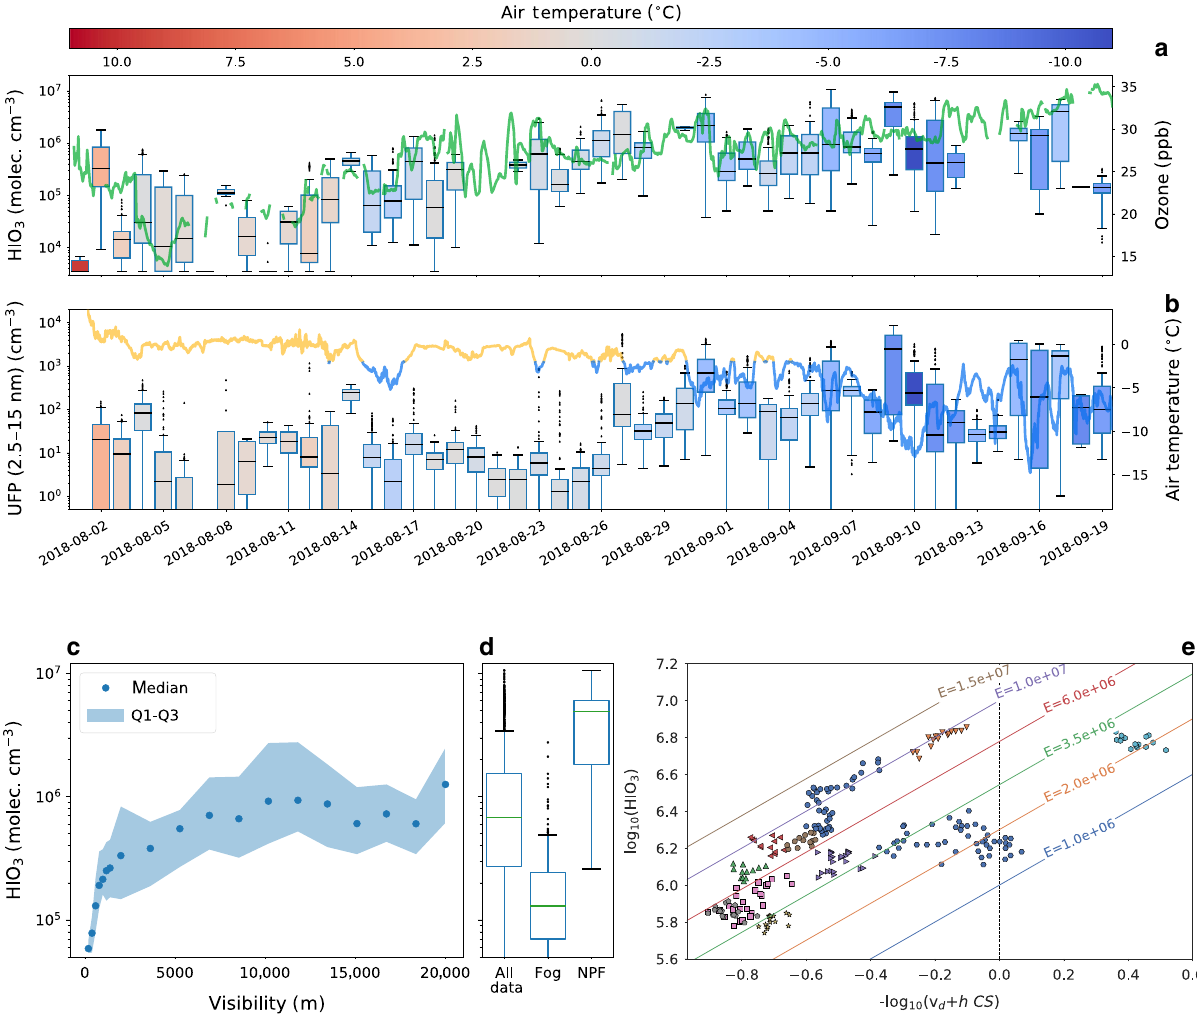
Fig. 2 Factors controlling iodic acid concentration and NPF over the pack ice in the central Arctic Ocean. a Daily box and whiskers plot of iodic acid, where the box extends from the fi rst quartile (Q1) to the third quartile (Q3) with a line indicating the median. The whiskers are set to 1.5*[Q3 – Q1]. The boxes are color-coded with the daily mean air temperature measured from the upper deck of the ship (roughly 25 m above sea level). The continuous green line shows the ozone concentration (axis on the right). b Daily box and whiskers plot of the ultra fi ne particle concentration (UFP), particles with a diameter between 2.5 and 15 nm. The continuous line shows the near-surface air temperature, with values lower than − 2 °C colored in blue and above in yellow (axis on the right). c Iodic acid concentration during autumn as a function of visibility, dots indicate the median and the shaded area the interquartile range [Q3 – Q1]. d Iodic acid concentration box and whiskers plot for different conditions during the autumn period. In particular, we report values for the entire autumn period, during fog (visibility below 2 km) and during NPF events. e Iodic acid data as a function of dry deposition velocity ( v d ), boundary layer height ( h ) and condensation sink (CS). Iodic acid data correspond only to clear conditions (visibility > 4 km) and periods when steady-state conditions could be assumed. Eleven steady-state periods are given by differently colored symbols. The colored lines represent different emission rates ( E ) based on our